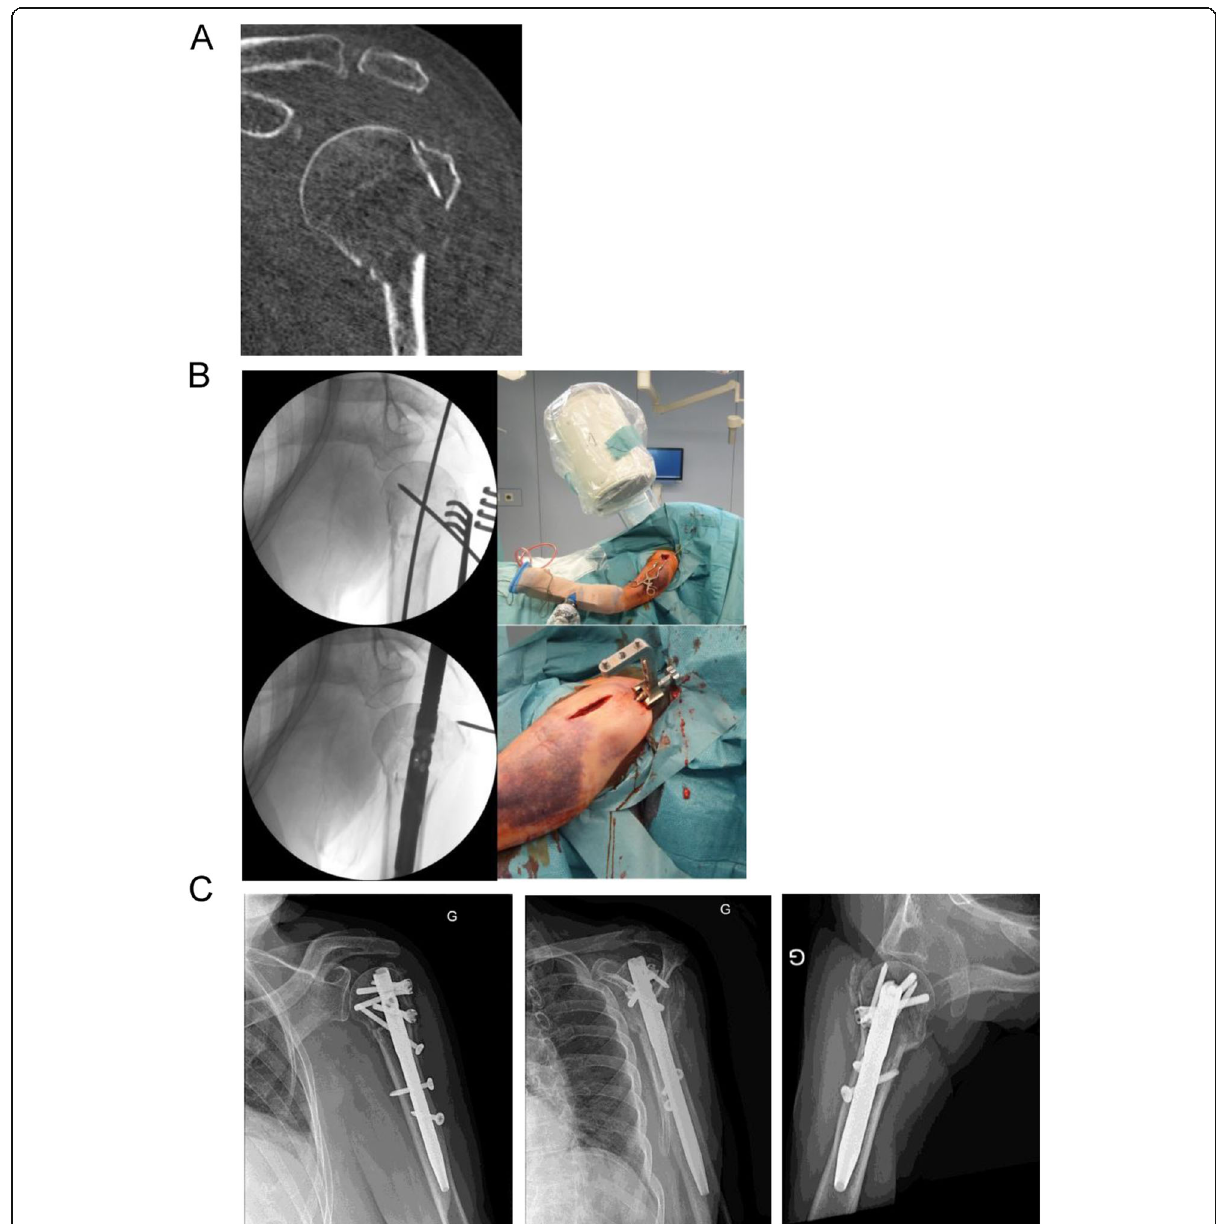
Kirschner wire: introduction of the nail via PN. Confirmation of the appropriate depth of the nail ( 1b ). Radiological follow-up at six weeks ( 1c